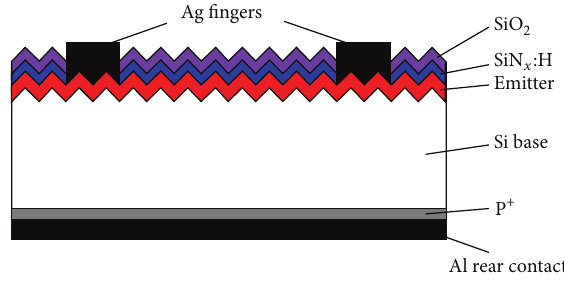
Figure 1: Schematic of the solar cell with SiO 2 /SiN